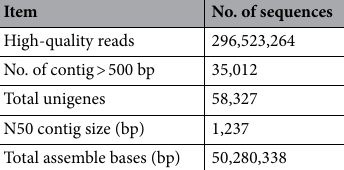
Table 2. Summary of the transcriptome data and the assembly results of Sophora